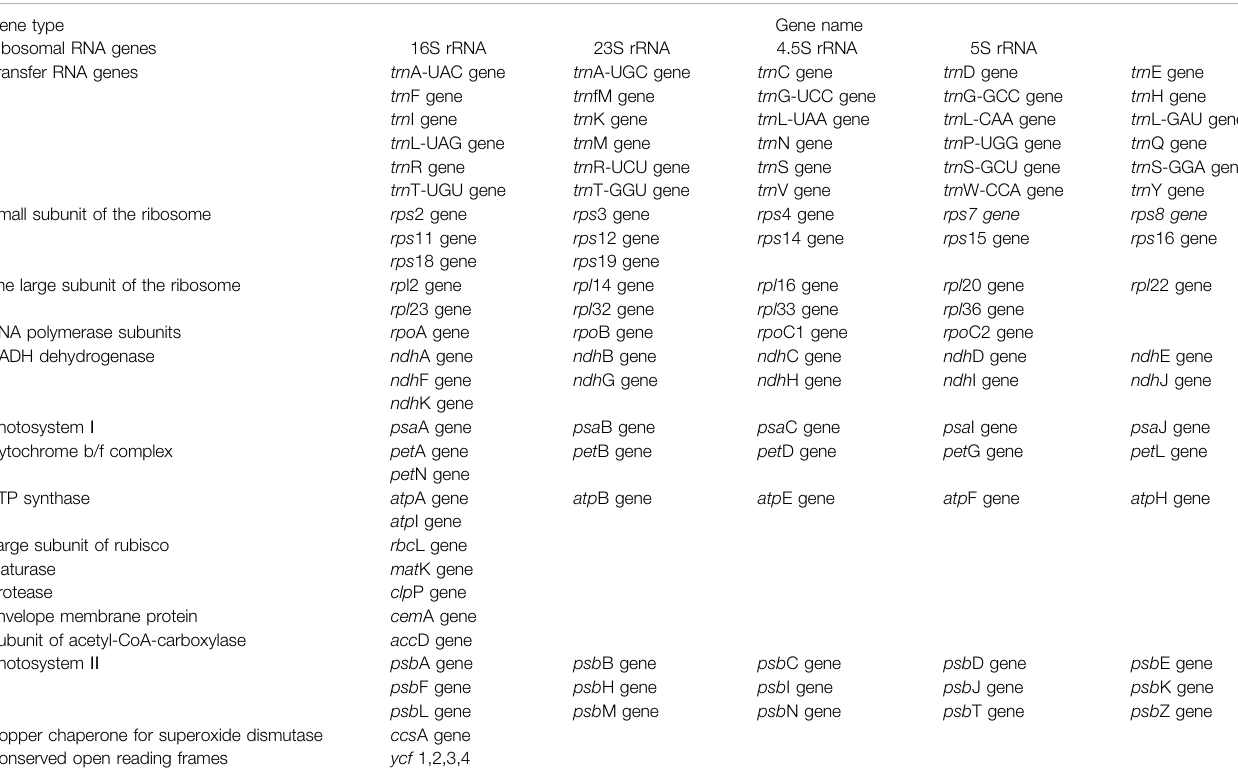
TABLE 1 | Genes present in the chloroplast genome of the 16 newly sequenced Epilobium , Circaea , and Chamaenerion samples. Gene